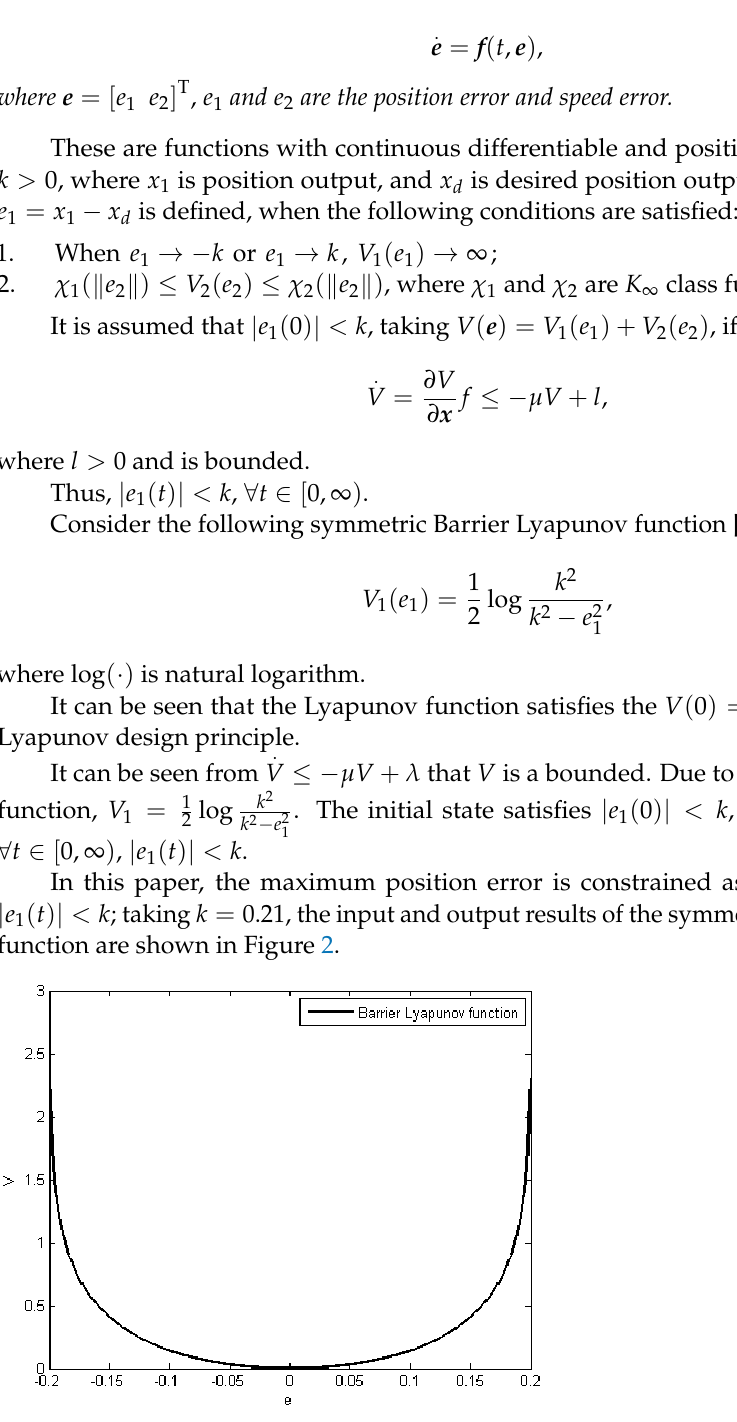
Figure 2. Symmetric barrier Lyapunov function.